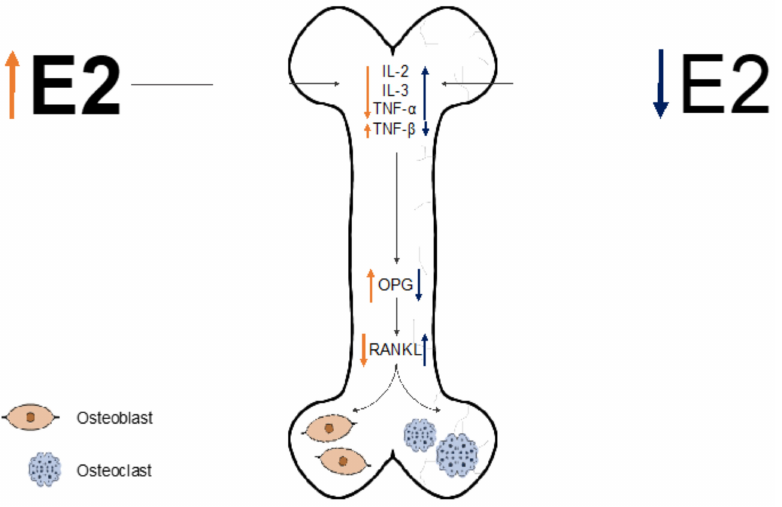
Figure 2. Protective effects of estrogen (E2) against osteoporosis. When there are low levels of E2 in the body, interleukin 2 (IL-2), interleukin 3 (IL-3), and tumor necrosis factor (TNF)- α are upregulated, while TNF- β is downregulated. The concerted effects of these increased levels of cytokines induce downregulation of competitive osteoprotegerin (OPG) and the upregulation of receptor activator of nuclear factor- κ B ligand (RANKL). Increased RANKL contributes to osteoclast differentiation, subsequently increasing bone resorption. Inversely, when there are higher levels of E2 in the body, IL-2/IL-3/TNF- α are downregulated, and TNF- β is upregulated-initiating a cascade of increased OPG and decreased RANKL expression. Osteoblast differentiation occurs at an increased pace (preserving bone integrity), particularly in osteoporosis-prevalent conditions, such as SCI. Orange arrows indicate pathway governing osteoblastogenesis, while blue arrows indicate pathway governing